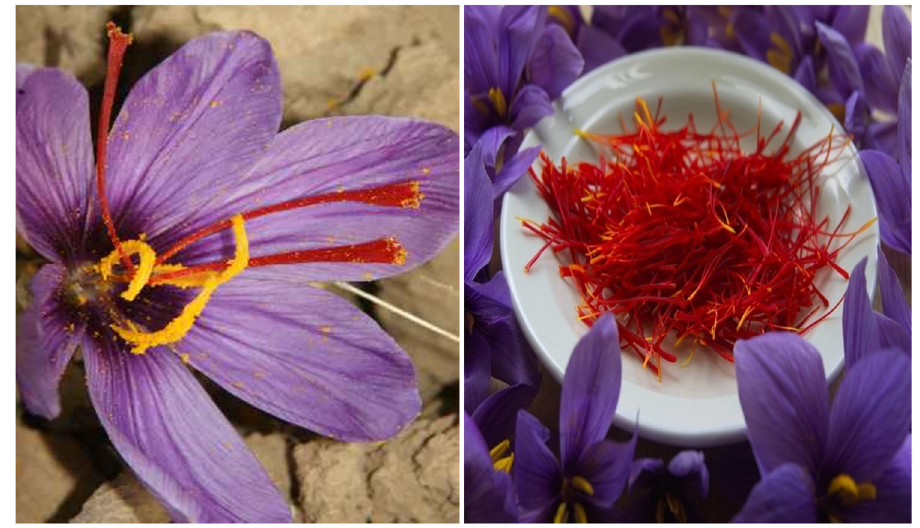
Figure 1: Sa ff ron ( Crocus sativus ) fl ower and